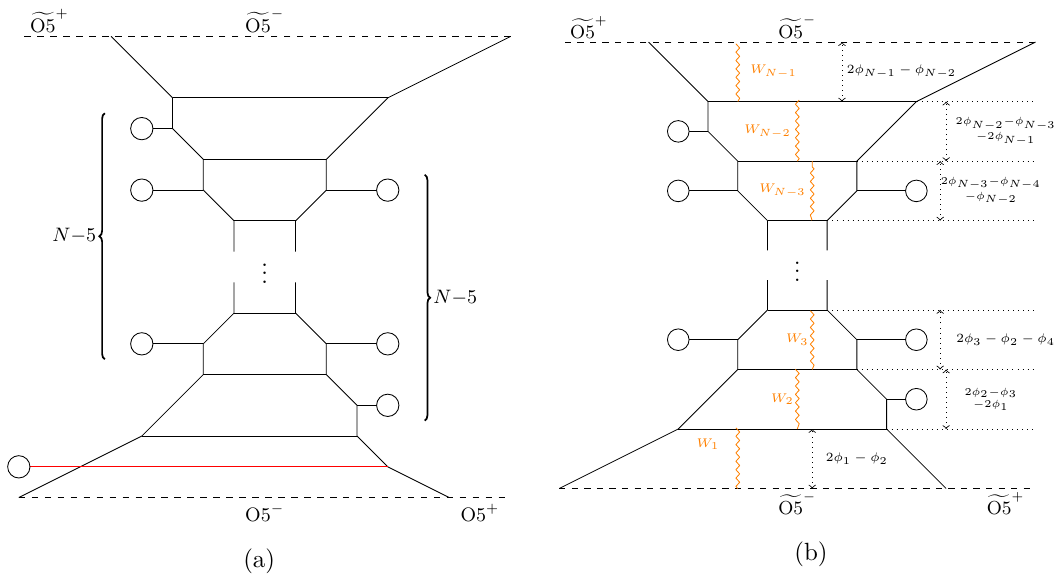
Figure 6. Partial Higgs mechanisms for the brane web of figure 5(b). In (a), the SO(2 N − 1) gauge symmetry is Higgsed to SO(2 N − 2) via moving the red brane segment onto the bottom O5-plane. The associated fundamental flavor is charged under the KK scale. In (b), the brane web for the Z 2 -twisted compactification of an SO(2 N − 2) theory with 2 N − 10 fundamentals is shown. The W-boson masses are functions of the dynamical Kähler parameter and the dependence is mediated via the Cartan matrix of b D (2) N − 1